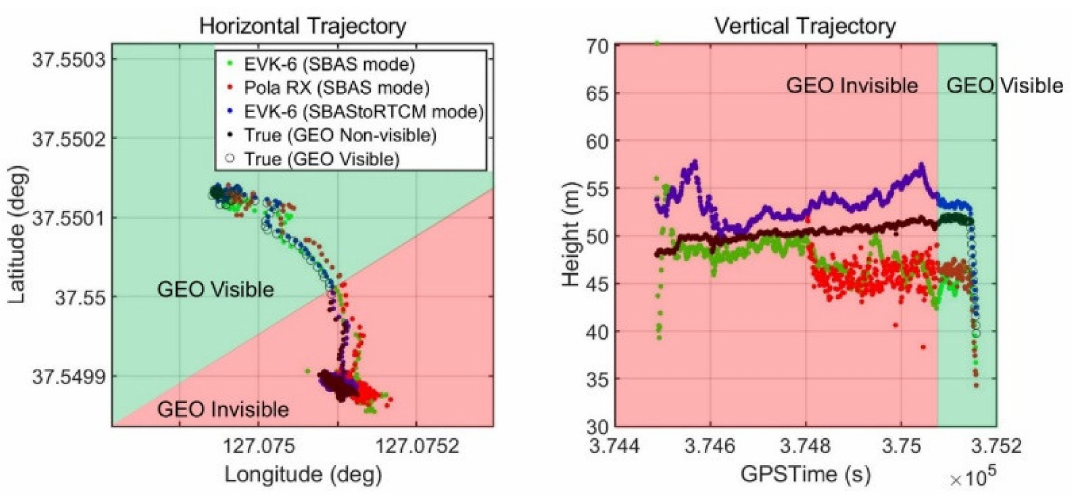
Figure 15. Drone flight trajectory and PRN #137